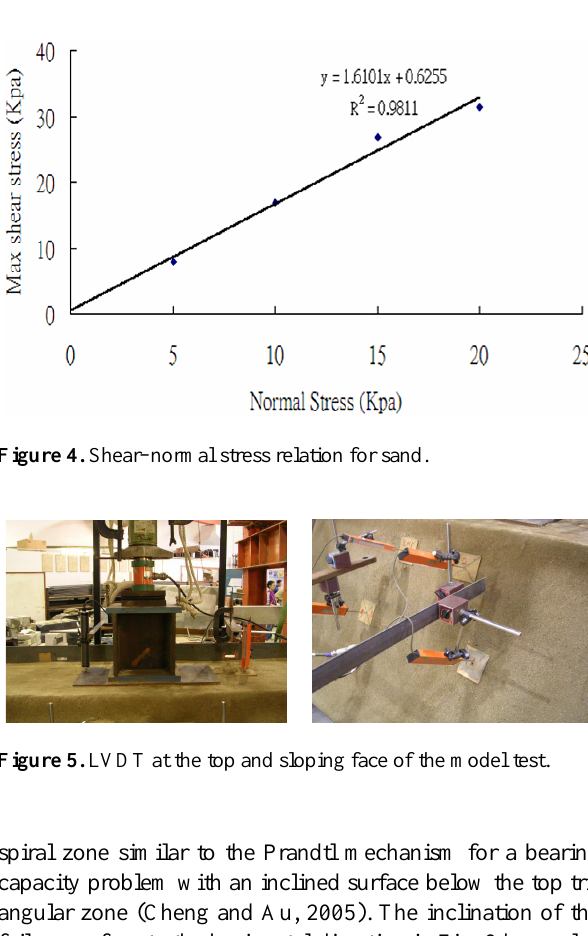
Table 1. Shear strength parameters of the river sand.